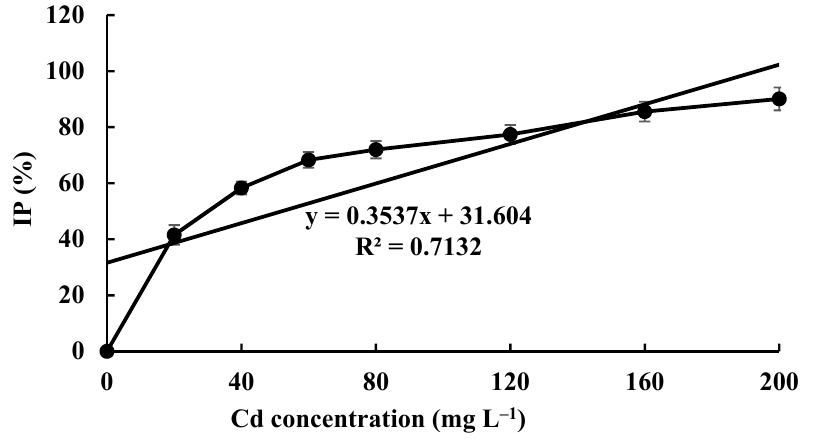
Figure 5. The inhibition percentage of Cd 2+ at different concentrations on H. chrysospermus.